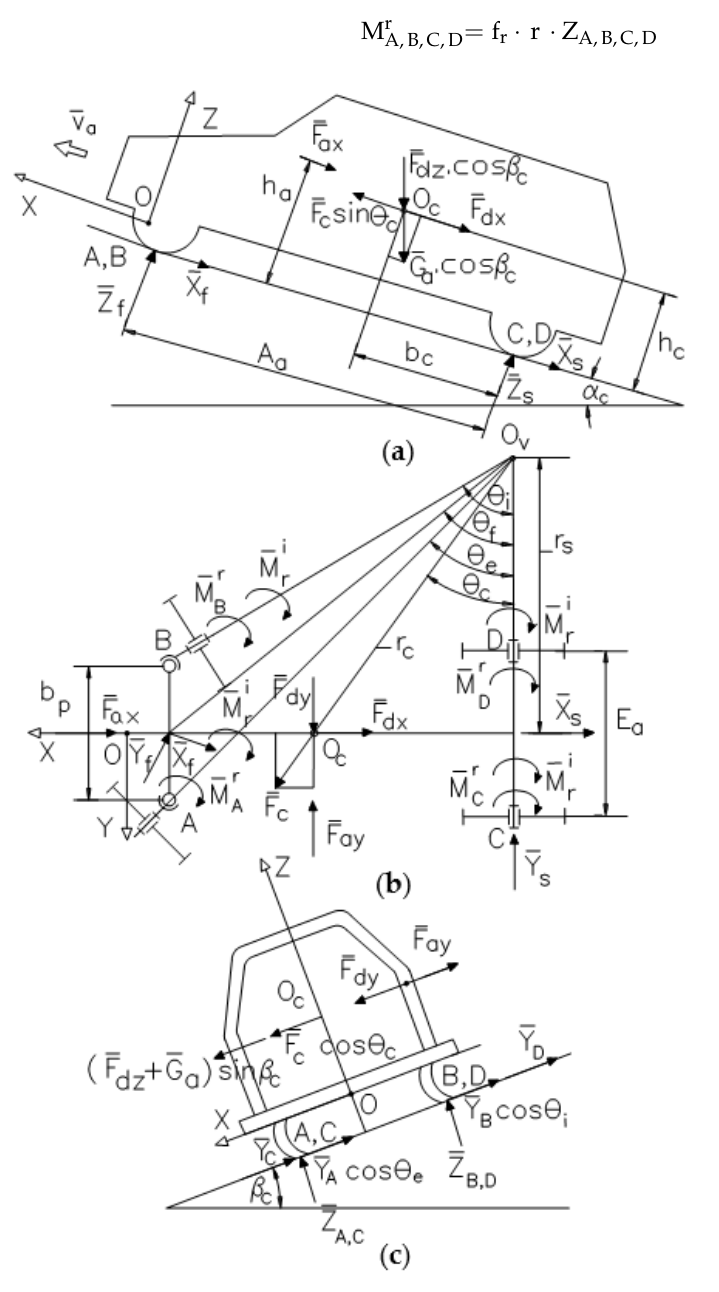
Figure 2. Forces acting on the car: ( a ) Forces in longitudinal–vertical plane; ( b ) forces and torques in longitudinal–transversal plane; ( c ) forces in transversal–vertical plane.